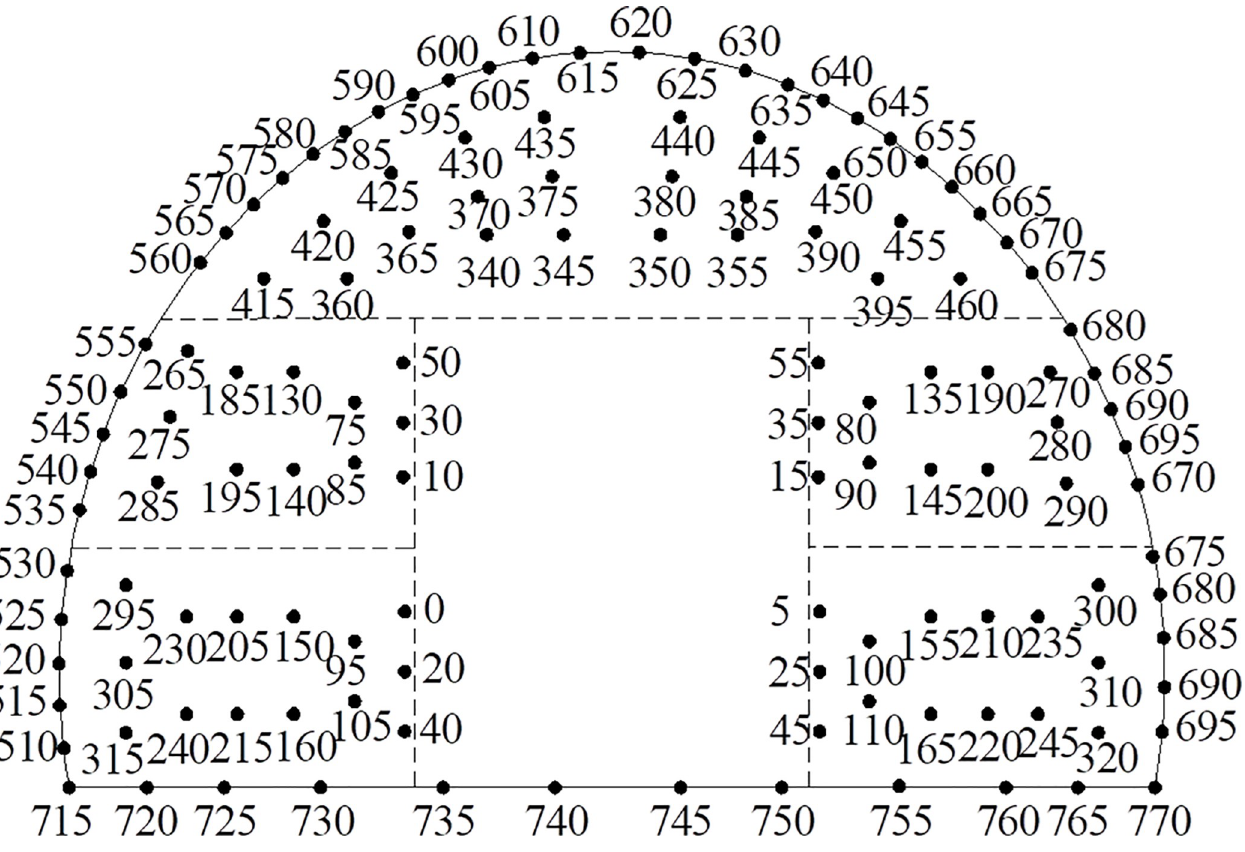
Fig 18. Layout and delay times of the tunnel holes (Unit: ms).